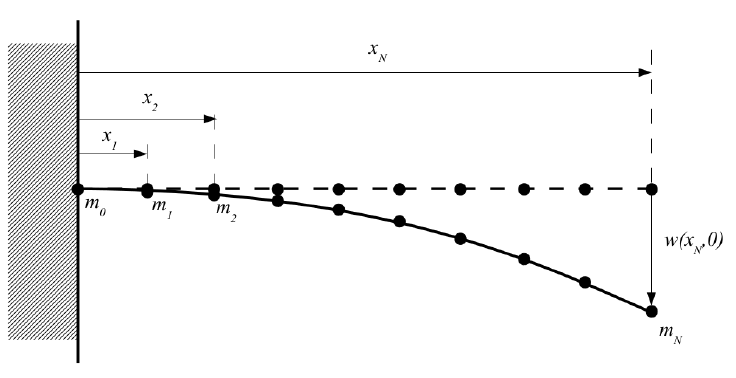
Figure 2. The computational domain used in the beam/finite difference